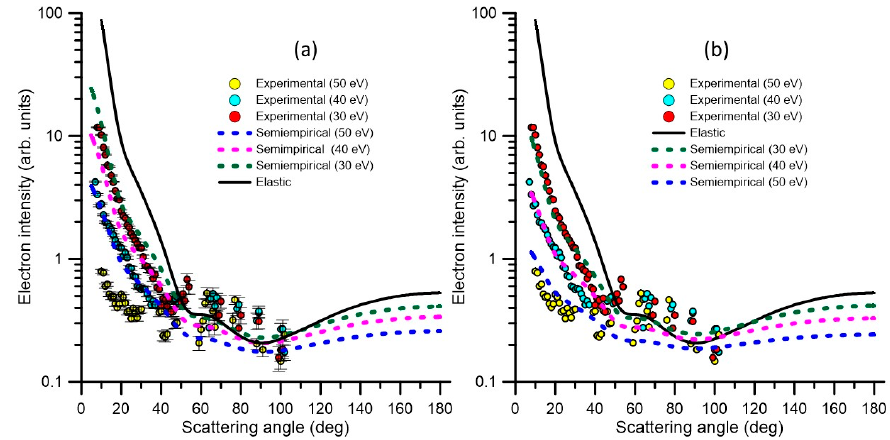
Figure 7. Comparison between the angular distributions given by the semi-empirical formulae (Equation (1) or (2)) for energy losses of 0 (elastic + rotational), 30, 40, and 50 eV, and those measured with the present reaction microscope for a 90 eV electron incident energy. ( a ) Using our previous semi-empirical formula (Equation (1)) and ( b ) using the present improved formula (Equation (2)) which is used to extrapolate to other energy losses.